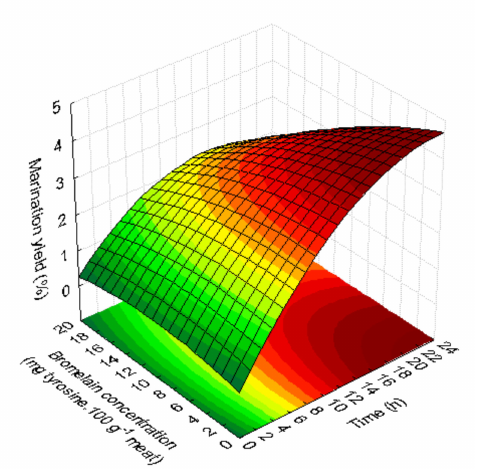
Figure 2. E ff ect of marinades on marination yield of the steaks as a function of marinades: bromelain concentration (mg tyrosine.100 g − 1 meat) and time